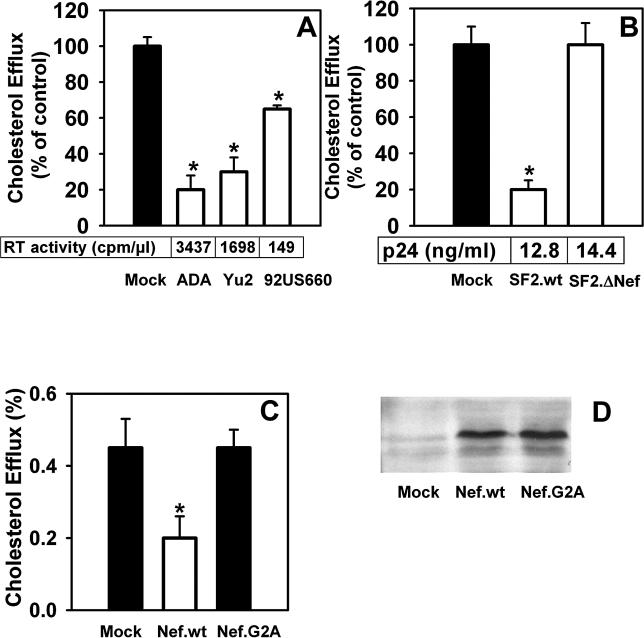
HIV-1 Nef Impairs Cholesterol Efflux from Macrophages(A) Monocyte-derived macrophages were inoculated with indicated HIV-1 strains equalized according to RT activity and cultivated for 21 d (RT activity in the culture supernatants on day 21 is shown beneath the bars). Mock-infected cells were incubated with virus-free medium. Specific cholesterol efflux to apoA-I (30 μg/ml) was performed for 12 h and analyzed as described in Materials and Methods. Results are presented as percentage of efflux from mock-infected cells (taken as 100%) and are mean ± standard deviation (SD) of triplicate determinations. An asterisk (*) indicates p < 0.001(B) Monocyte-derived macrophages were inoculated with VSV-G-pseudotyped HIV-1 SF2 either deficient in Nef (SF2.ΔNef) or carrying WT Nef (SF2.wt). Specific cholesterol efflux to apoA-I (30 μg/ml) was analyzed on day 6 after inoculation using the same procedure as described in (A). p24 concentration in the culture medium is shown beneath the bars. Results are presented as percentage of efflux from mock-infected cells (taken as 100%) and are mean ± SD of triplicate determinations. An asterisk (*) indicates p < 0.001.(C) RAW 264.7 cells were transfected with plasmids expressing indicated Nef variants or an empty vector (mock-transfection). Twenty-four hours after transfection, LXR agonist, TO-901317 (1 μmol/L), was added. Cholesterol efflux to apoA-I (30 μg/ml) was performed for 3 h with cells 48 h after transfection as described in Materials and Methods. Means ± SD of quadruplicate determinations are shown. An asterisk (*) indicates p < 0.001.(D) Immunoblotting of RAW 264.7 cells transfected with empty vector (mock), WT Nef derived from HIV-1 strain SF2 (Nef.wt), or Nef.G2A mutant, and stained with anti-Nef antibodies.